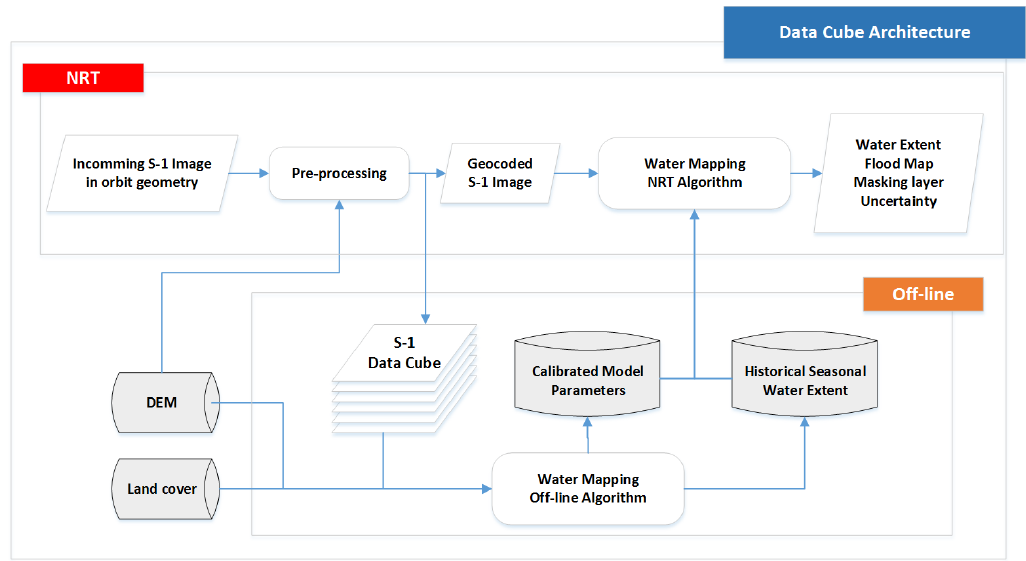
Figure 4. Data cube processing architecture for global flood monitoring using Sentinel-1 SAR image data, consisting of an NRT data flow and off-line